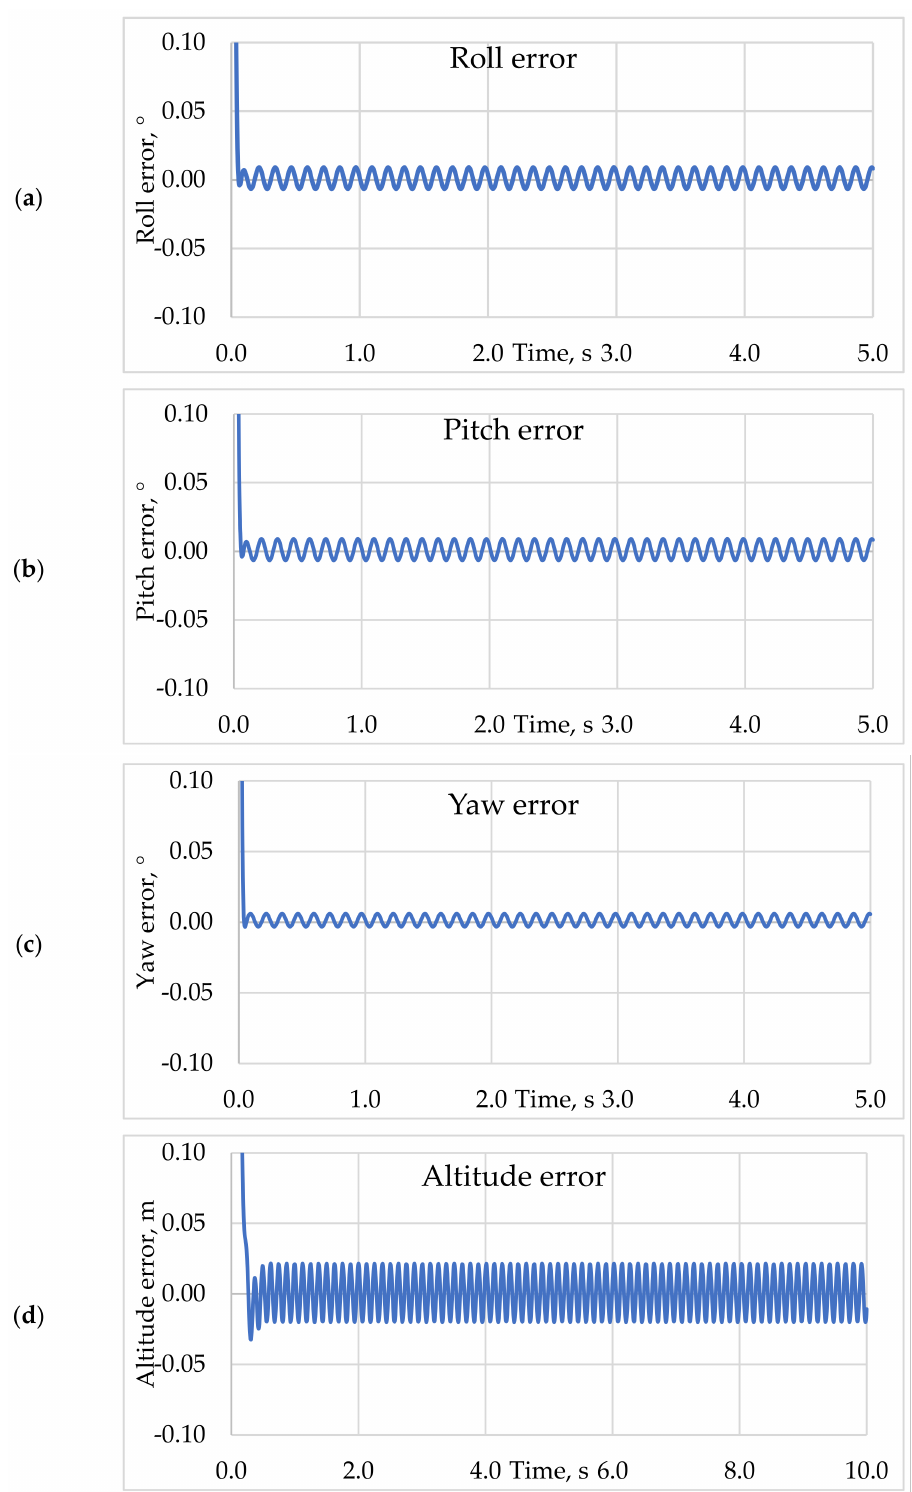
Figure 7. The response of the altitude and attitude error of the system, ( a ) roll, ( b ) pitch, ( c ) yaw, and ( d ) altitude